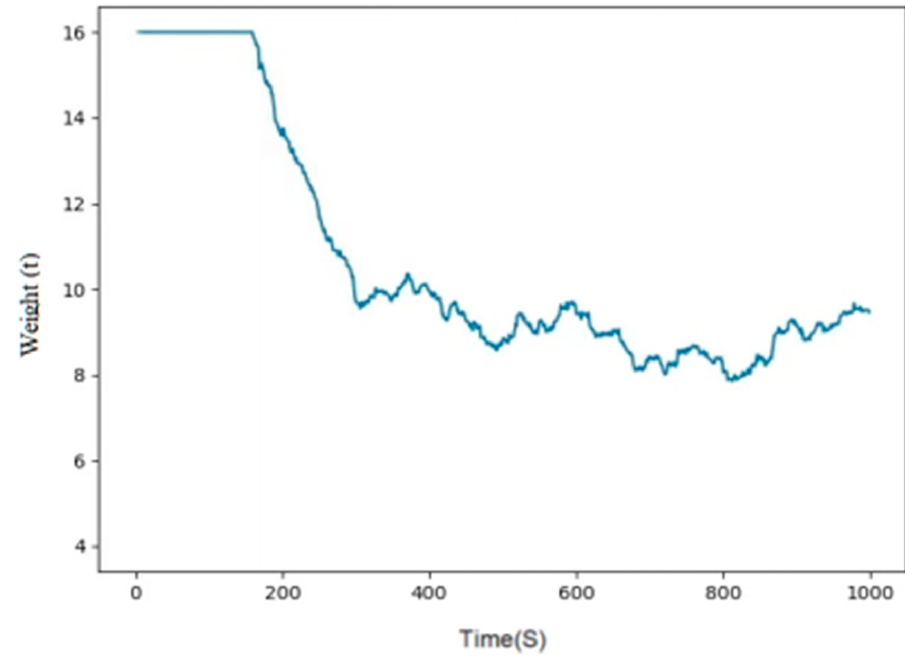
Figure 14. PID control response curve to changing production conditions.